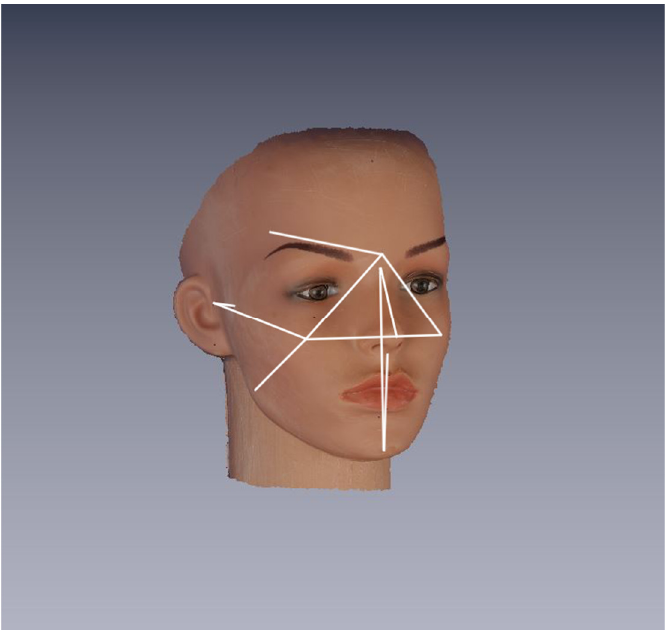
Figure 2. Dummy: linear distances between anthropometric points. A three-quarter projection of the dummy’s head with a representation of linear distances measured on the 3D image between pre-labeled